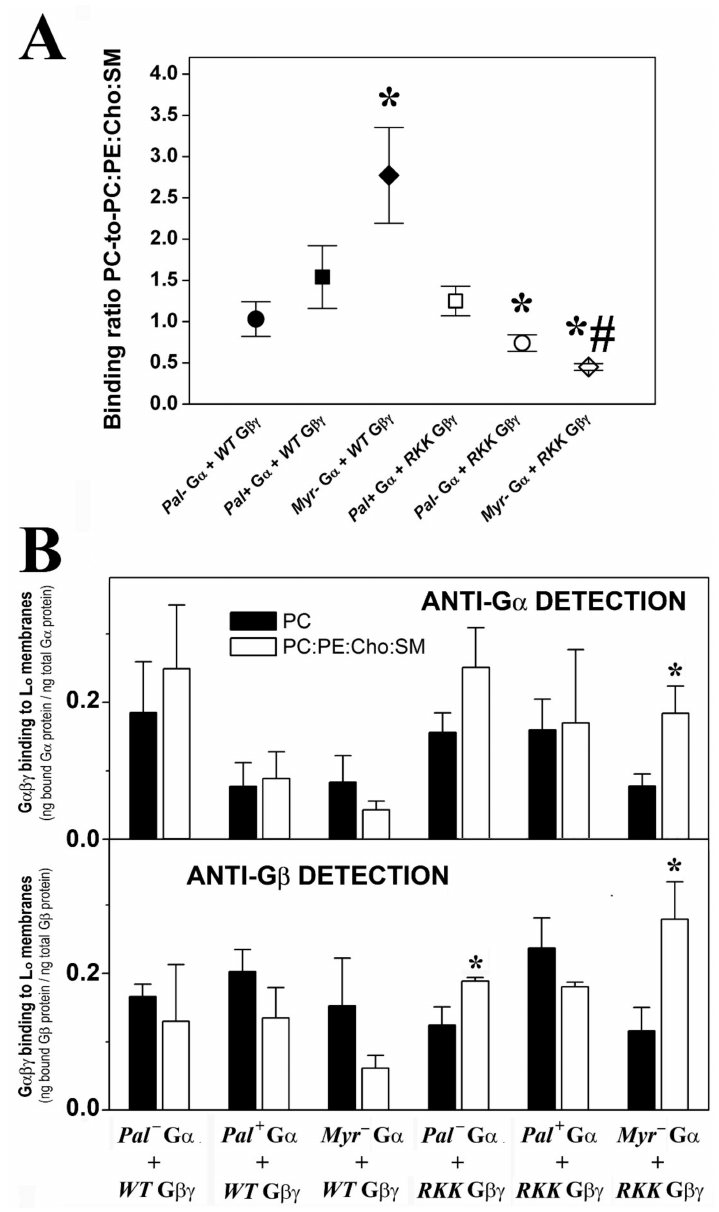
Figure 7. Effect of membrane lipid order and G α i 1 / γ 2 structure on G αβγ –membrane interactions. ( A ), PC-to-PC:PE:Cho:SM binding ratio of the different G α i 1 β 1 γ 2 heterotrimer constructs. The ratios are calculated considering the respective G α i 1 and G β 1 fractions bound to PC relative to their corresponding fractions bound to PC:PE:Cho:SM (1:1:1:1, mol:mol) in each independent experiment. The data represent the mean ± S.E.M. values: * p < 0.05 with respect to PC membranes; # p < 0.05. ( B ), Binding of G α i 1 β 1 γ 2 heterotrimers to PC and PC:PE:Cho:SM membranes. The bars in the upper panel show the mean binding of the heterotrimers to PC and PC:PE:Cho:SM membranes, calculated as the bound G α i 1 subunit relative to the total G α i 1 subunit. In the lower panel, the binding is calculated as the bound G β 1 subunit relative to the total G β 1 subunit. The colors of the bars in the lower panel are equivalent to those in the upper panel and in both panels representative immunoblots of each binding experiment are shown. The data represent the mean ± S.E.M.: * p < 0.05 with respect to PC